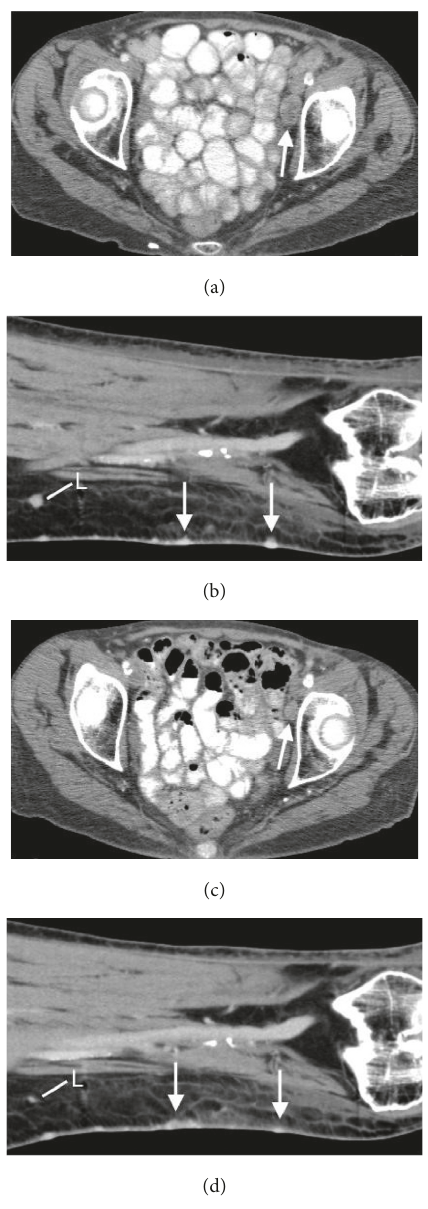
Figure 2: Progression of the disease despite treatment with carboplatin, paclitaxel, and radiotherapy (a, b), with subsequent partial treatment response two months afterstarting capecitabine (c, d). Axial postcontrast CTs of the pelvis show metastatic left pelvic lymph nodes, with decrease in size of a metastatic left external iliac chain lymph node from 2.2 × 1.1cm (white arrow, a) to 1.5 × 0.9cm (white arrow (c)) with capecitabinetreatment.CoronalpostcontrastCTsoftheleftleg(b)before and (d) after capecitabine treatment show similar cutaneous metastases (white arrows) with decreased size of a metastatic lymph node